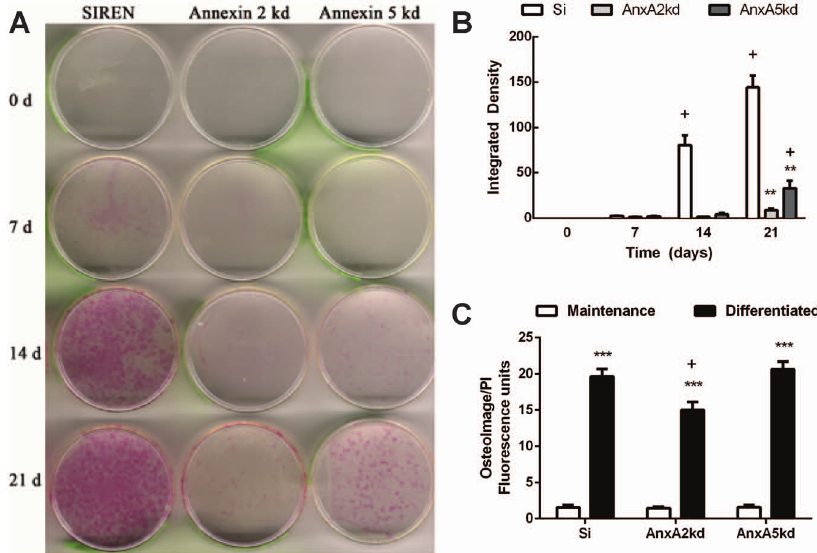
Figure 4. Effects of AnxA2 and AnxA5 knockdown on ALP and hydroxyapatite. (A) ALP activity staining in MC3T3-E1 cells (MC3T3), Si, AnxA2 kd and AnxA5 kd cells after culture in osteogenic differentiation media for 7, 14 and 21 days, representative images from n=3 biological replicates. (B) Quantitation of ALP staining intensity. Bars represent mean integrated signal intensity 6 SEM, n=3. + represents statistically significant difference from same genotype on day 0, p , 0.05. **represented statistically significant different from Si at the same day, p , 0.01. (C) OsteoImage staining for hydroxyapatite in Si, AnxA2 kd and Anx5 kd cells cultured with differentiation media for 5 weeks. Each bar represents OsteoImage fluorescence normalized to PI 6 SEM, n=3. ***represents statistically significant difference from maintenance media within the same genotype, ***p , 0.001; + represents statistically different from Si in same media composition, p , 0.01.